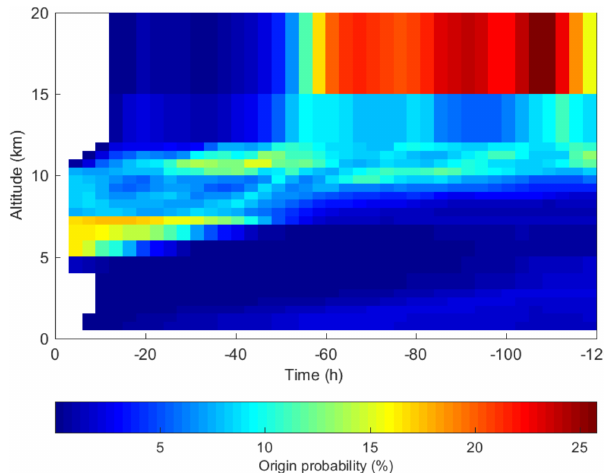
Figure 8. Time–altitude distribution of probability (in %) of back- trajectory origin when initiated within the domain 24–26 ◦ N, 120– 122 ◦ E (4–10km altitude), on 6 July at